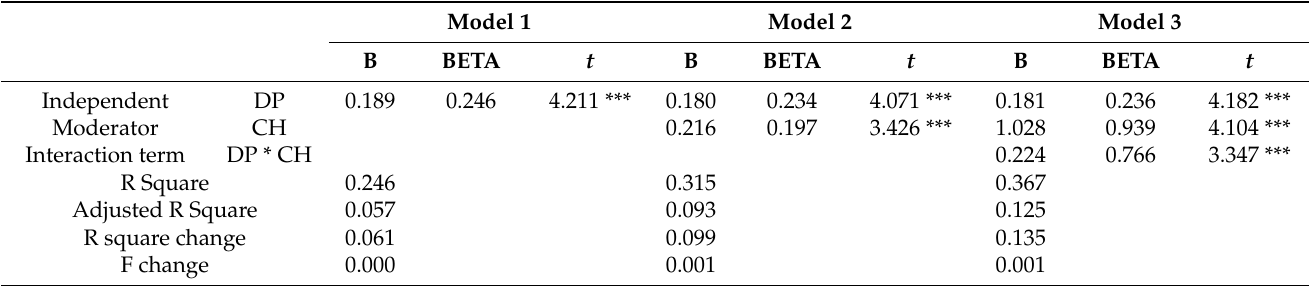
Table A3. Hierarchical regression for the moderation analysis: the moderating effect of coping humor in the path between defensive pessimism and the re-entry